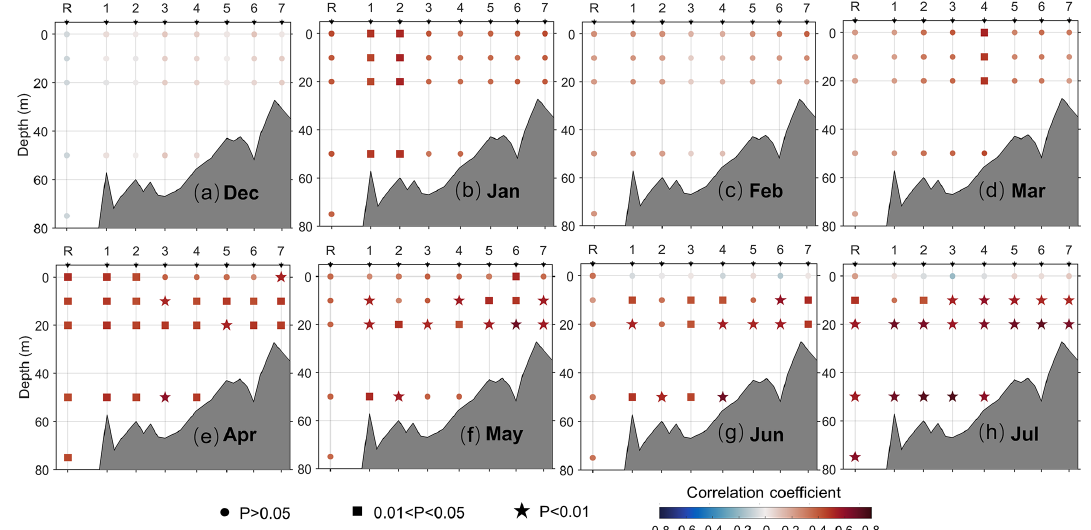
Figure 5. Correlation coefficients for interannual variation of water temperature at each station from the previous December to July (a– h) and that of the Iyo-Nada bottom cold water mass (INCWM) mean water temperature in July during 1994–2015. Circles indicate that the significant confidence level is less than 0.95, squares indicate a significant confidence level is between 0.95 and 0.99, and stars indicate a significant confidence level of more than